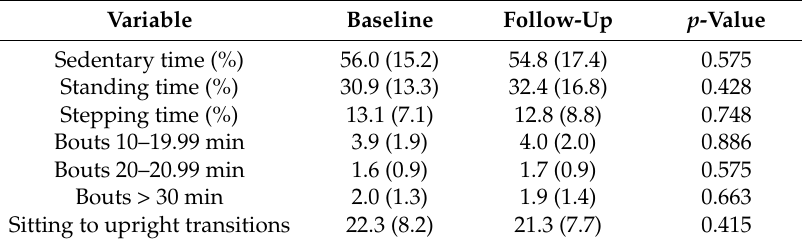
Table 4. Intervention outcomes working